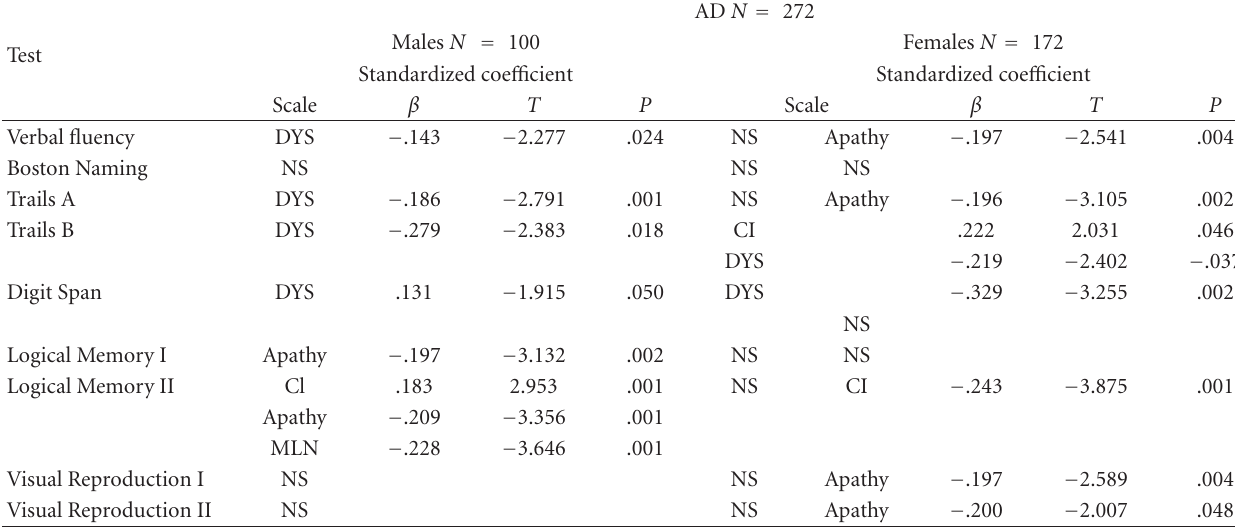
Table 3: GDS subscales and neuropsychological tests for Alzheimer’s group by gender ∗